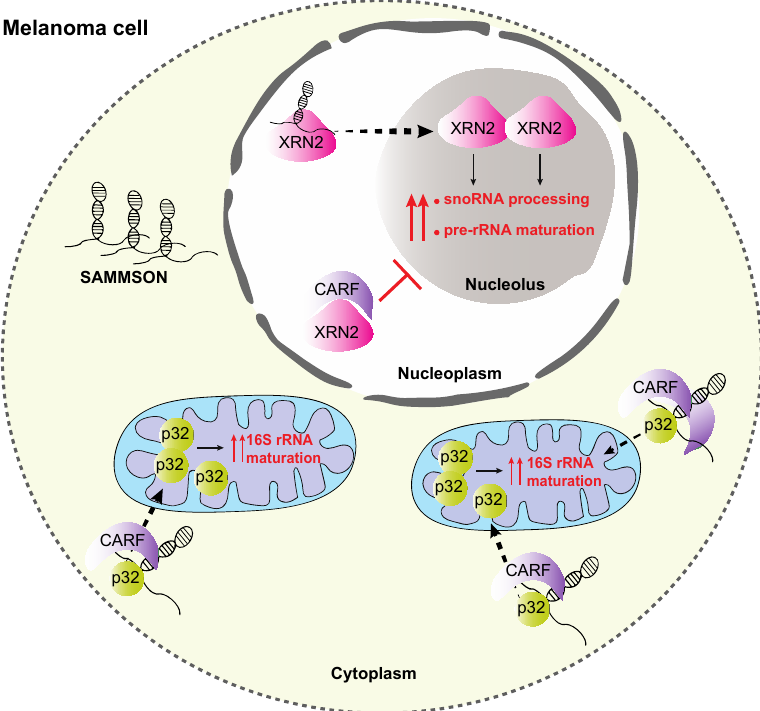
Figure 7. Schematic representation of SAMMSON regulatory role in pre-rRNA processing. SAMMSON is a lncRNA that is aberrantly expressed in melanoma cells. In the cytoplasm of a melanoma cell, SAMMSON interacts with CARF and then with p32, which is transferred in the mitochondria and promotes the mitochondrial 16S rRNA maturation. Moreover, in the nucleus of a melanoma cell, SAMMSON interacts with XRN2 to induce the snoRNA and pre-rRNA in the nucleolus.